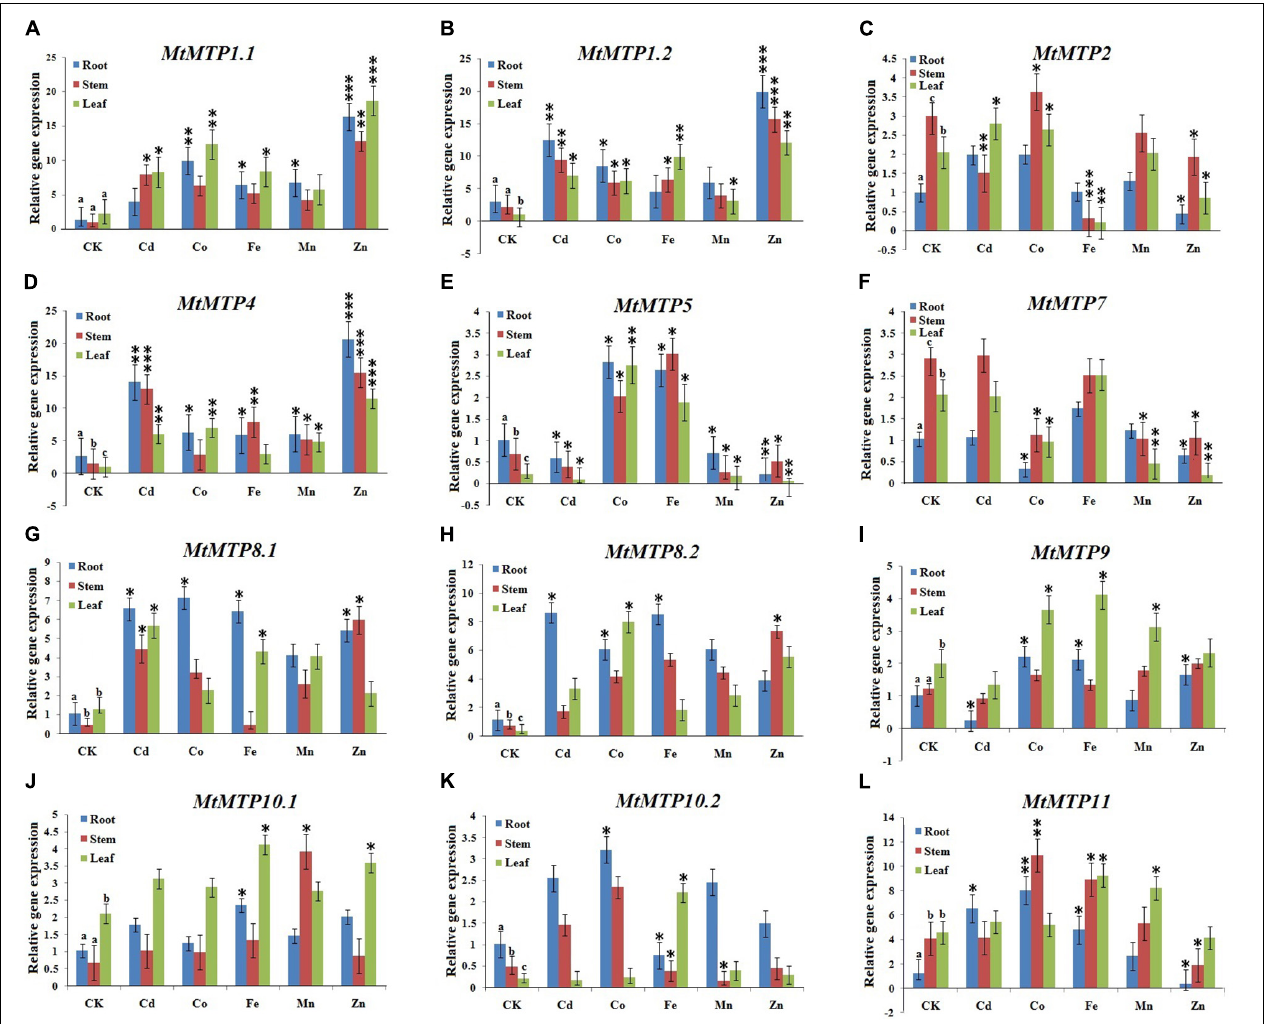
FIGURE 9 | The qRT-PCR expression of the M. truncatula MTP genes from root, stem and leaf samples where the genes where showed alphabetically from (A–L) . The reactions were normalized using the β - actin reference gene. The standard deviations have been represented by the error bars from three independent technical replicates. The mean expression levels of the three replicates were analyzed with the five heavy metal treatments (Cd 2 + , Co 2 + , Fe 2 + , Mn 2 + , and Zn 2 + ) using t -tests ( p < 0.05), where as the CK represents the control samples. Different letters (a, b and c) indicate significant differences between the roots, stems, and leaves under normal conditions. Asterisks indicate significant differences between the treatment samples and the corresponding control samples in the roots, stems, and leaves ( n = 9, p < 0.05, Student’s t